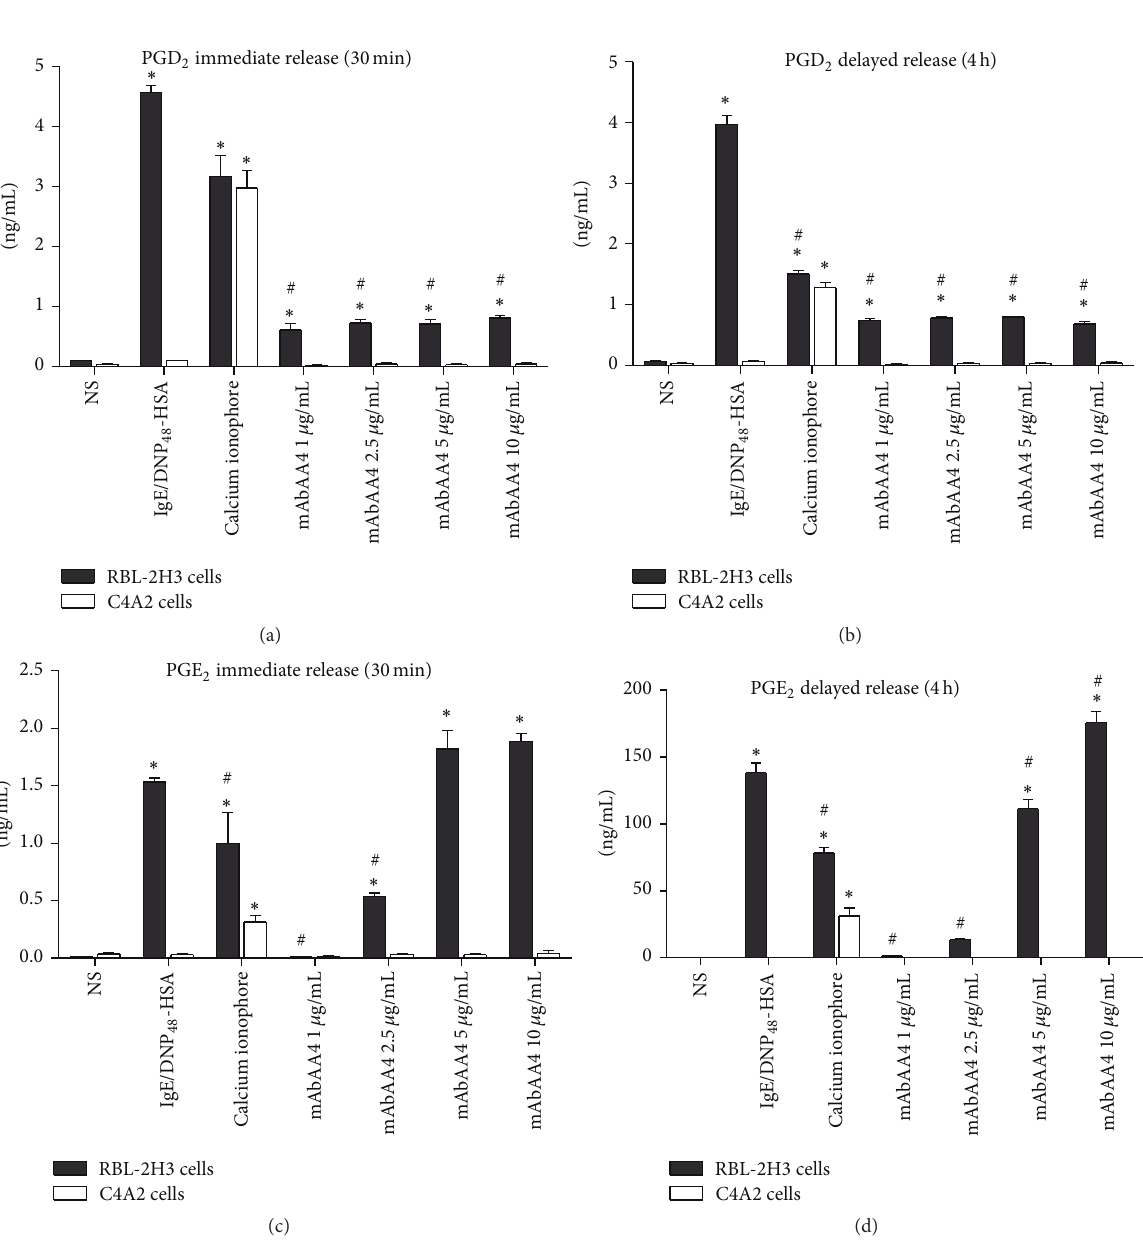
Figure 1: Cross-linking GD1b derived gangliosides by mAbAA4 induced Syk-dependent release of PGD 2 and PGE 2 . For stimulation via Fc 𝜀 RI, RBL-2H3 cells and C4A2 Syk-negative cells were sensitized with IgE anti-TNP and stimulated with DNP 48 -HSA (50ng/mL). For Fc 𝜀 RI independent stimulation, the cells were incubated with calcium ionophore (0.1 𝜇 g/mL). To cross-link GD1b derived gangliosides, cells were incubated with mAbAA4 (1, 2.5, 5, and 10 𝜇 g/mL). Nonstimulated (NS) cells were used as negative controls. Culture supernatants were collected after 30 min of incubation to evaluate immediate release (a and c) or cells were incubated for 1h and rinsed and cultured for an additional 3h and culture supernatantswere collected to evaluate delayed release (band d). PGD 2 (a and b)and PGE 2 (cand d) were measured in the culture supernatant by EIA. Data is expressed as the mean ± SD of three independent experiments. ∗ 𝑃 < 0.05 between experimental samples and the nonstimulated (NS) cells. # 𝑃 < 0.05 between experimental samples and Fc 𝜀 RI stimulated RBL-2H3